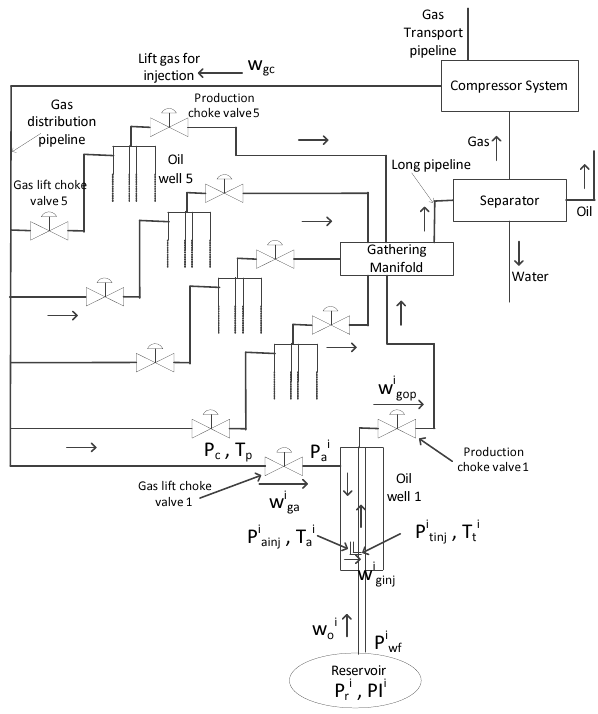
Figure 1: Schematic of an oil (cid:28)eld with (cid:28)ve oil wells